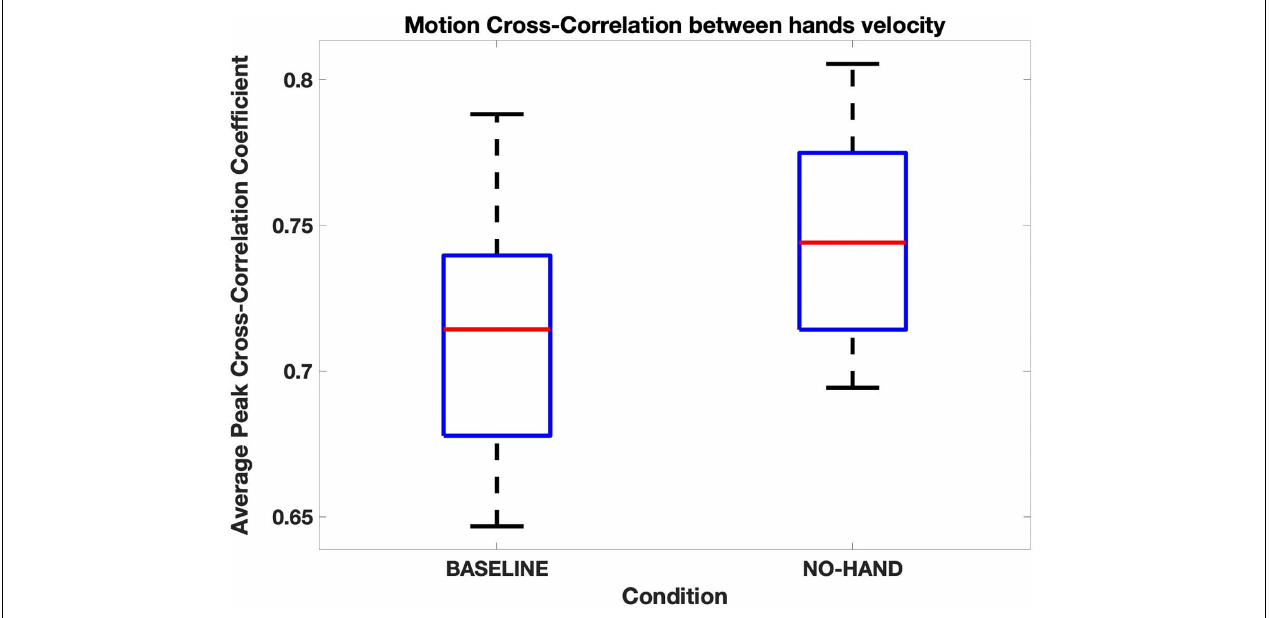
FIGURE 6 | Motion cross-correlations between hands’ velocity. Average peak cross-correlation coefficients were significantly higher when participants couldn’t see their own hands (NO-HAND) than when they did (BASELINE).